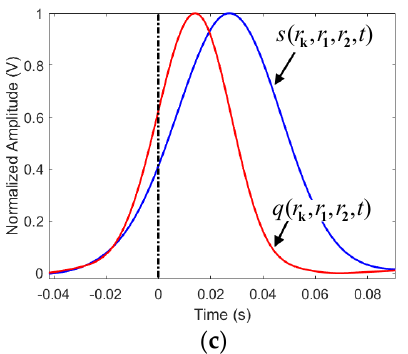
( , , , ) s t r r r at various 1 2 k